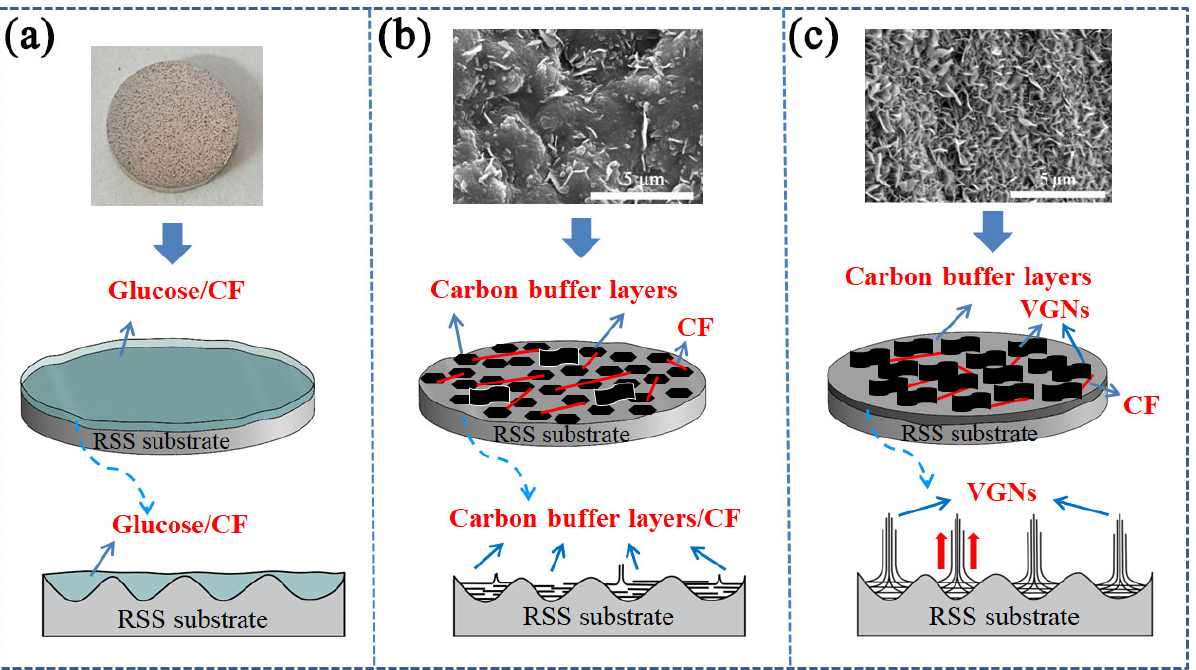
Figure 7. Schematic diagram of the growth mechanism of VGNs/CF composite film on the surface of the RSS substrate: ( a ) early-growth stage, ( b ) growth stage, ( c ) stabilization stage.